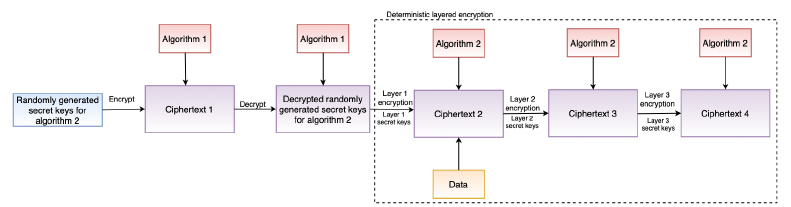
Figure 3. Architecture of encryption